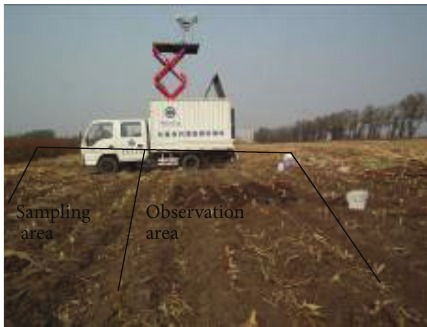
Figure 2: Soil surface after removing corn stalks.